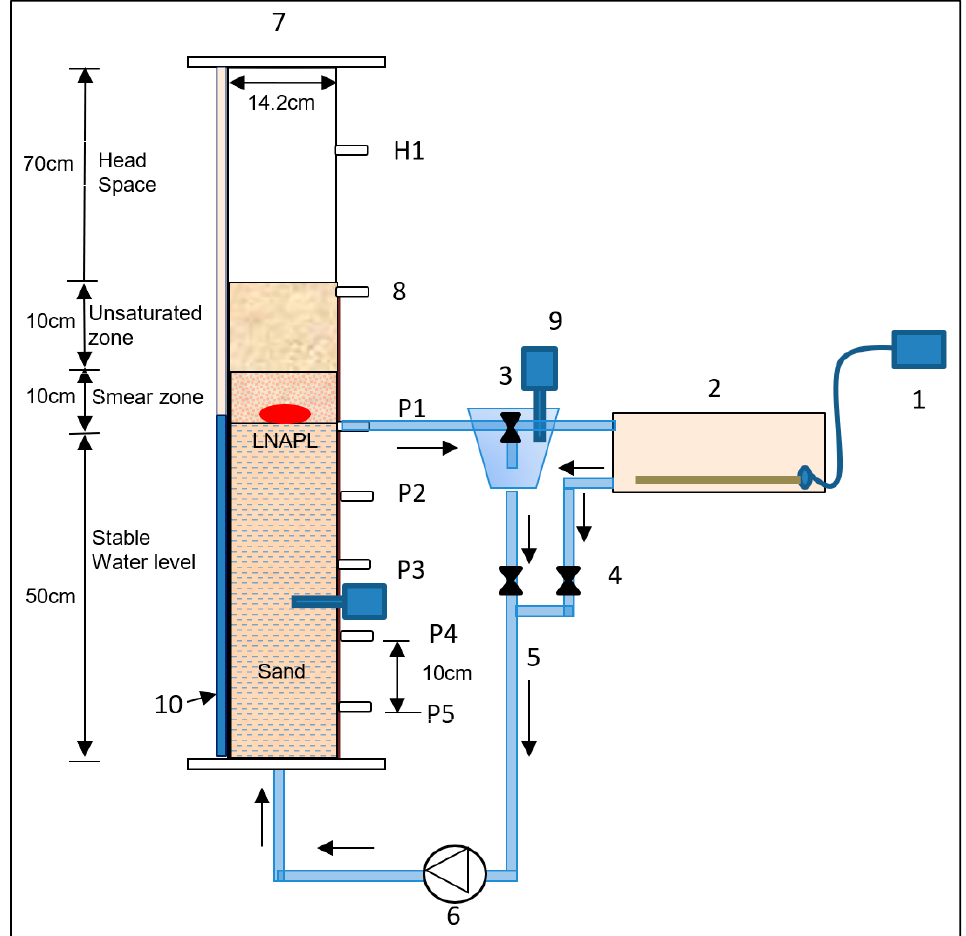
Figure 1. Schematic diagram of the laboratory 1D column setup used to investigate the thermally enhanced bioremediation of NAPL in soil-water. 1: Electric board; 2: hot water bath; 3: cold water bath; 4: flow controlling valve; 5: viton tube cover with cotton; 6: peristaltic pump; 7: column setup; 8: injection port; 9: thermometer; 10: piezometer; P1-P4 are sampling ports. A tracer transport experiment was performed first to estimate vertical dispersivity.